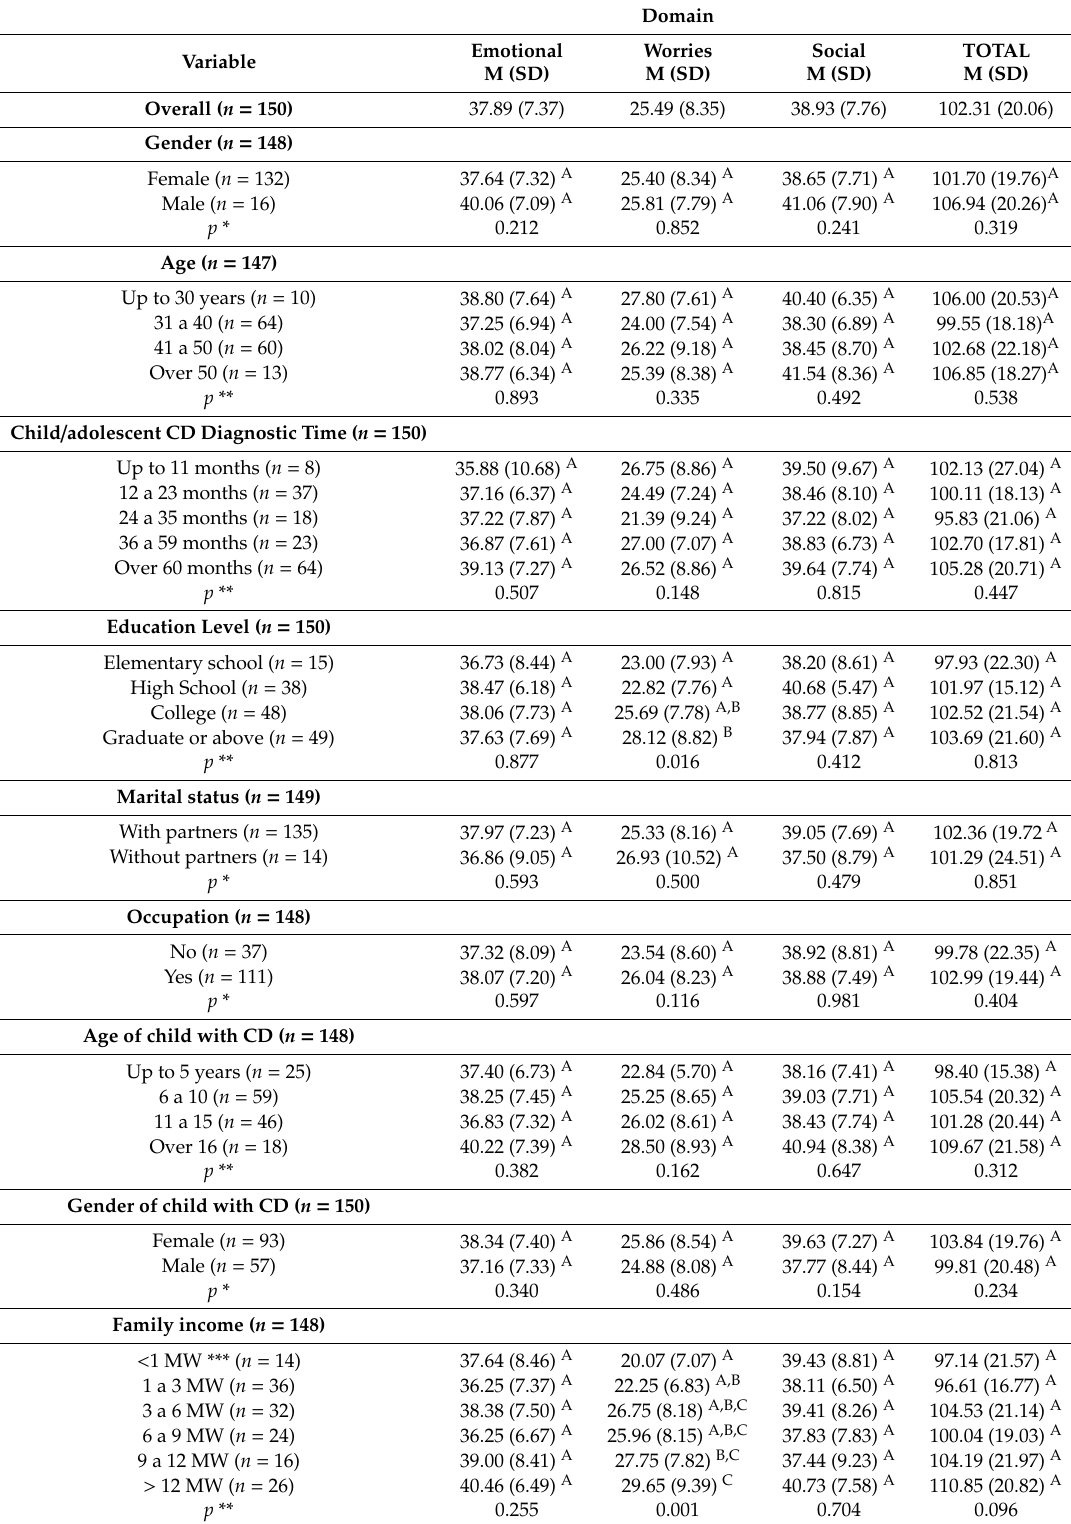
Table 2. Mean (M), standard deviation (SD), and p -value of comparison of the CDPCA-QoL questionnaire scores (and their domains) according to study